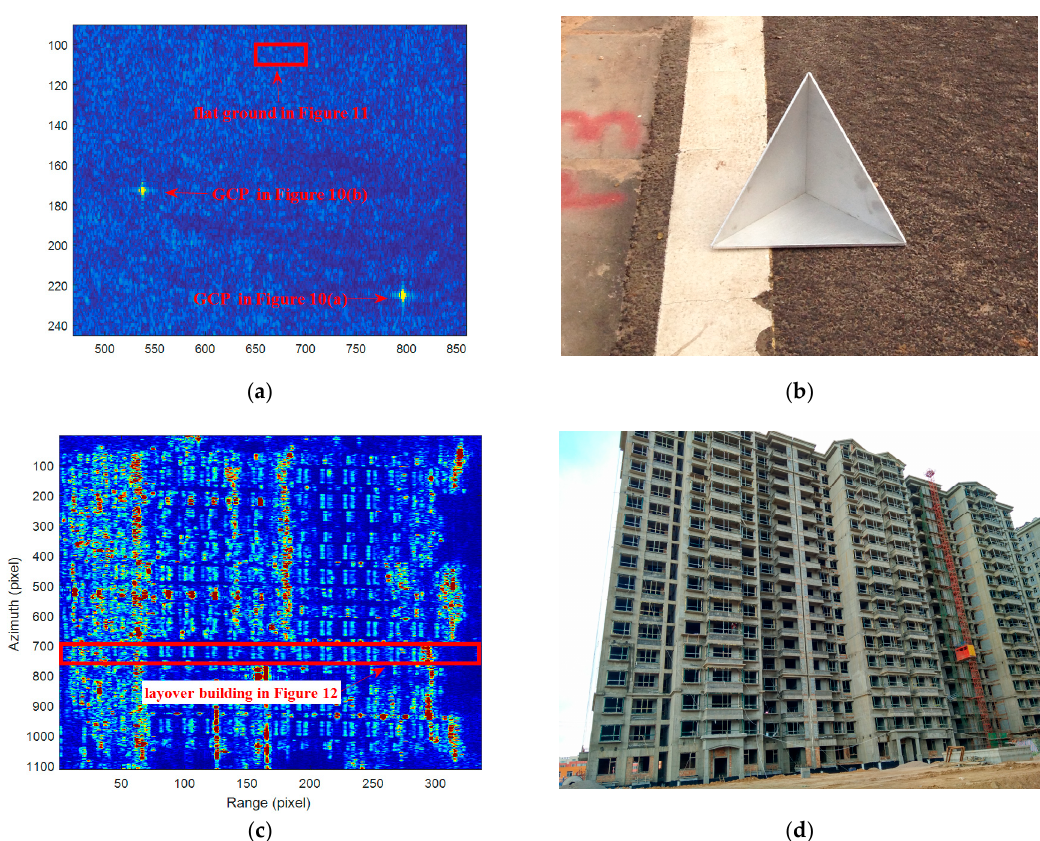
Figure 8. The SLC images and corresponding optical images. ( a ) SLC image of GCPs and the flat ground; ( b ) Optical image of one GCP; ( c ) SLC image of the layover building (the red block is the area corresponding to Figure 12); ( d ) Optical image of the building in ( c ).